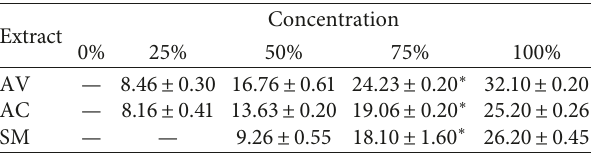
Table 2: Complete inhibition zone (mm) of the plant extracts in several concentrations.